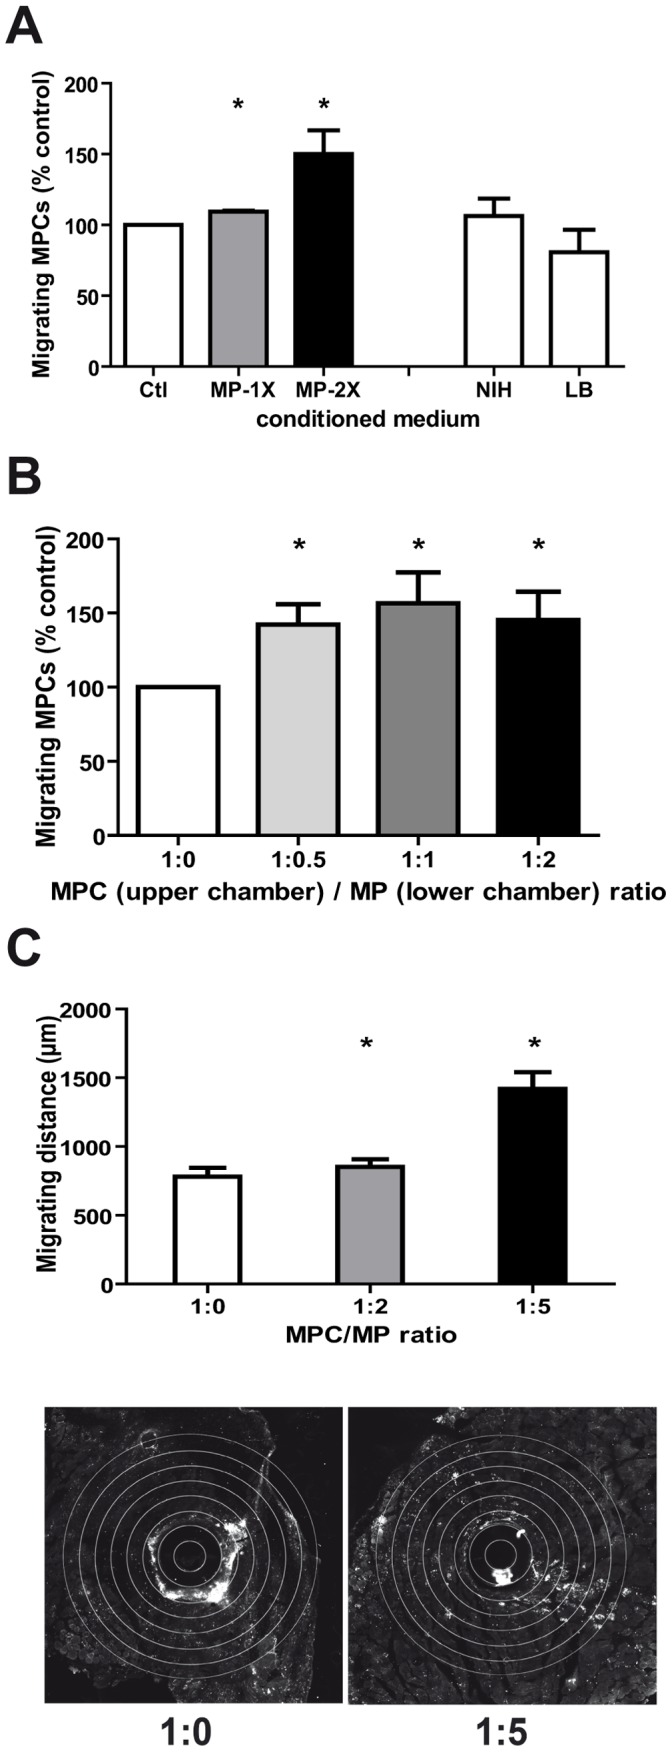
Effects of MPs on MPC migration in vitro and in vivo.(A) MPCs were seeded in the upper chamber of chemotactic inserts with or without MP-conditioned medium at various concentrations or with NIH-3T3 fibroblast-conditioned medium of B lymphocyte-conditioned medium. In (B) MPs were seeded in the lower chamber at various densities. The number of migrating cells was counted 24 h later and migration was expressed in % of migrating cells counted in control medium. (results represent mean ± sem of 3 independent experiments). * = P<0.05. (C) GFP-MPCs were injected with or without MPs at various ratios through a microtube migrating device in mdx TA muscle as described in Materials and Methods. After 48 h, migration of cells is evaluated by calculating the distance of cells from the microtube and expressed in µm. (results represent mean ± sem of 3 independent experiments). * = P<0.05. On bottom, representative micrographs show migration of MPCs from the microtube, when injected alone (1∶0) or with MPs (1∶5).